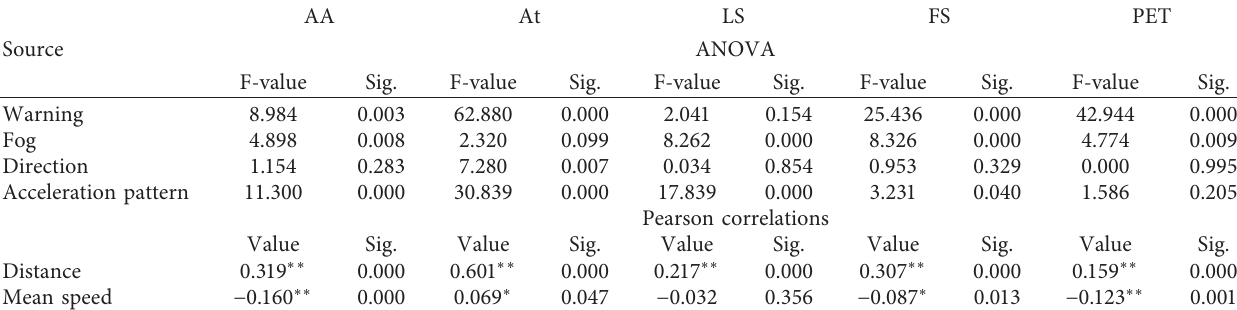
Table 5: ANOVA and the Pearson correlation results of AA, AT, LS, FS, and PET.